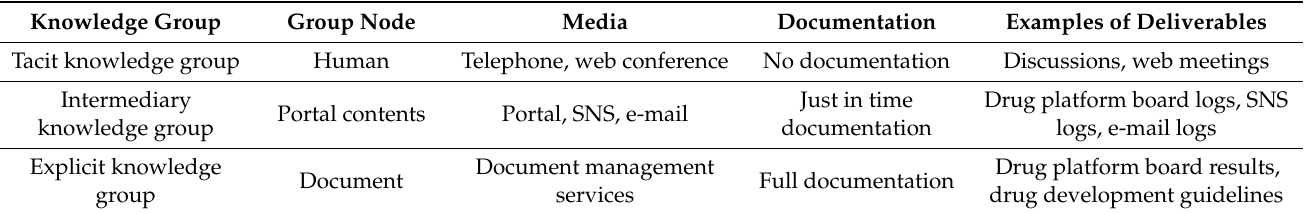
Table 2. Elements of layers in GDTC model for drug